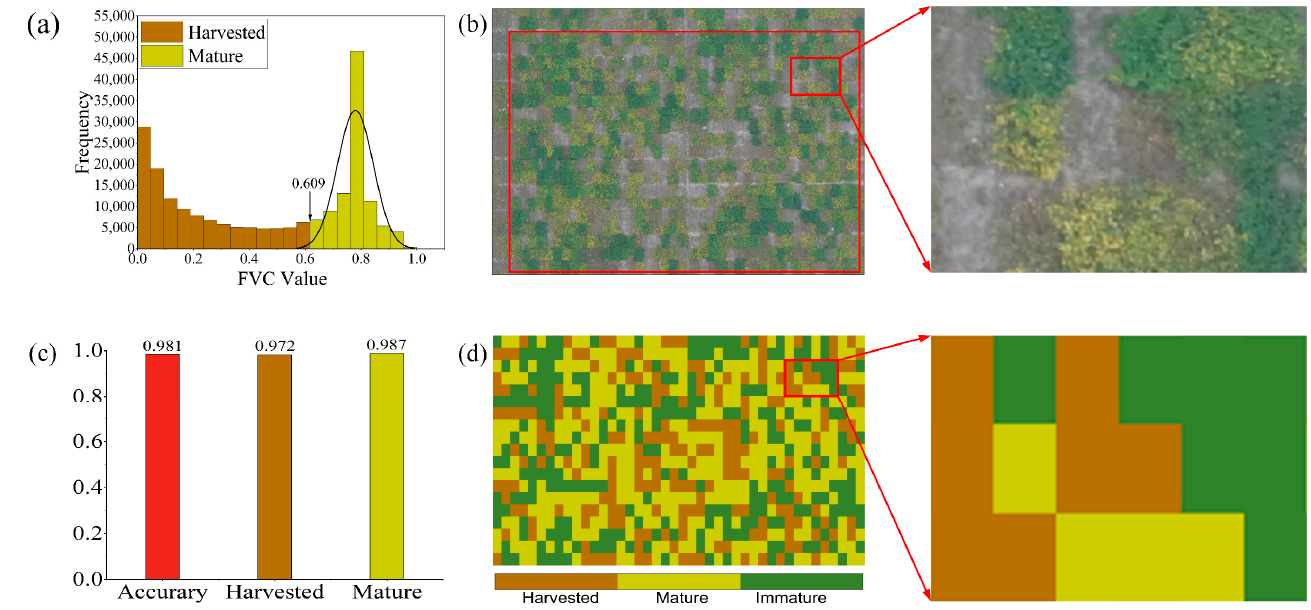
Figure 11. Harvest monitoring results for P4 (mature) soybean: ( a ) histogram of FVC anomaly distribution for P4; ( b ) P4-RGB; ( c ) P4 harvest monitoring accuracy; ( d ) P4-FVC threshold visuali-